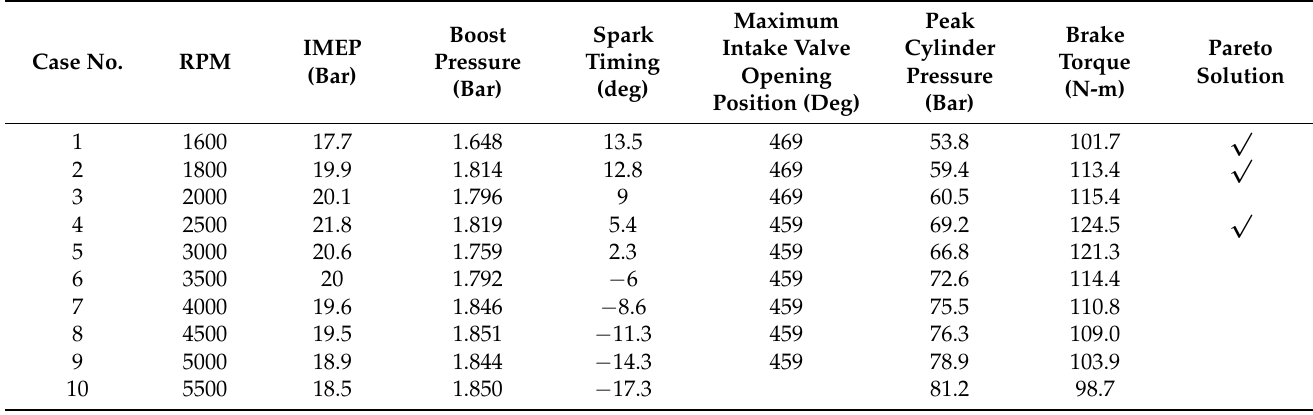
Figure 2. Schematic of the engine testing device from KATECH, South Korea. Table 2 summarizes the operating conditions used in the experiments. Table 2. Experimental conditions for target Gasoline MPI Turbo SI engine.